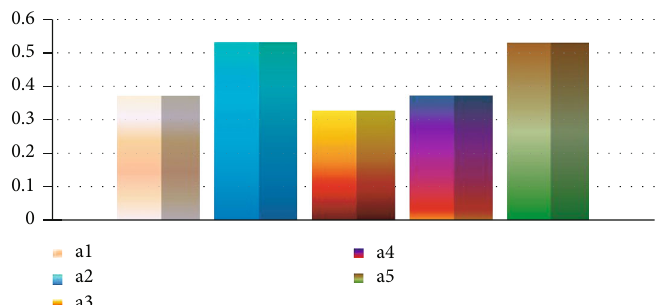
Figure 2: Priority order of the green